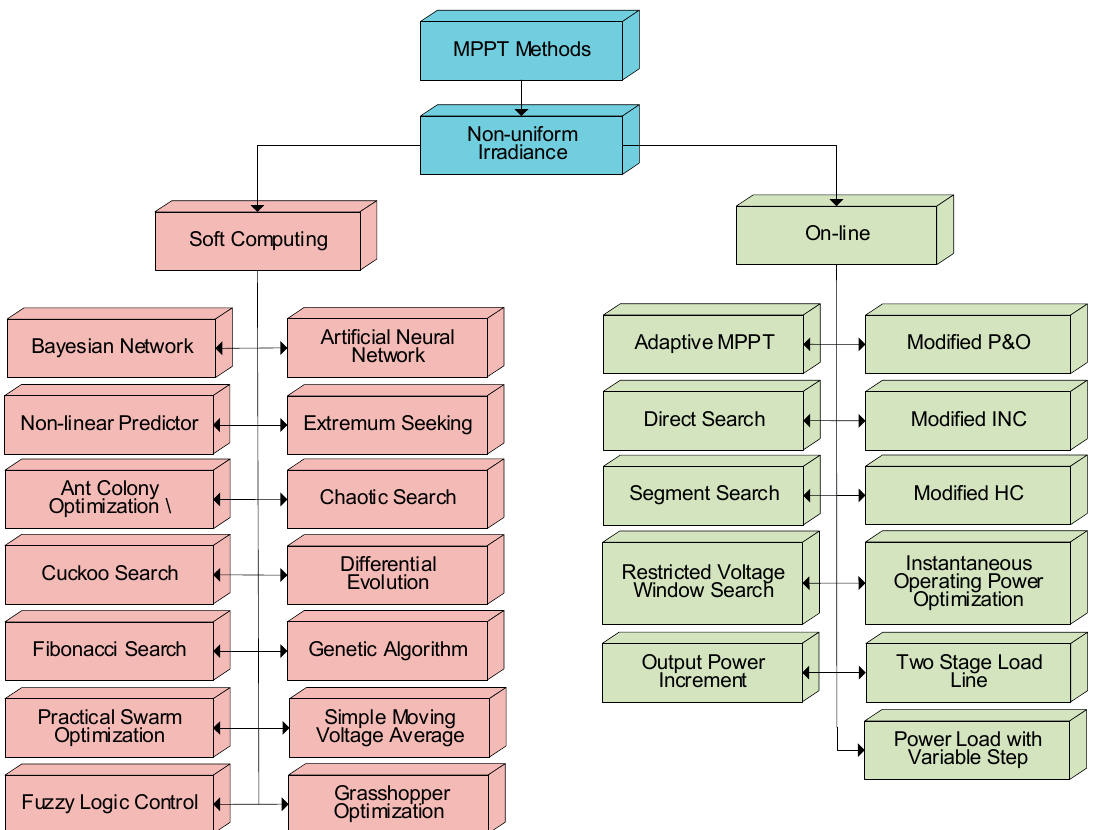
Figure 2. Maximum power point tracking techniques classification.